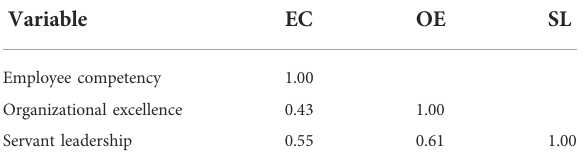
TABLE 6 Summary of questionnaires. TABLE 5 Latent variable